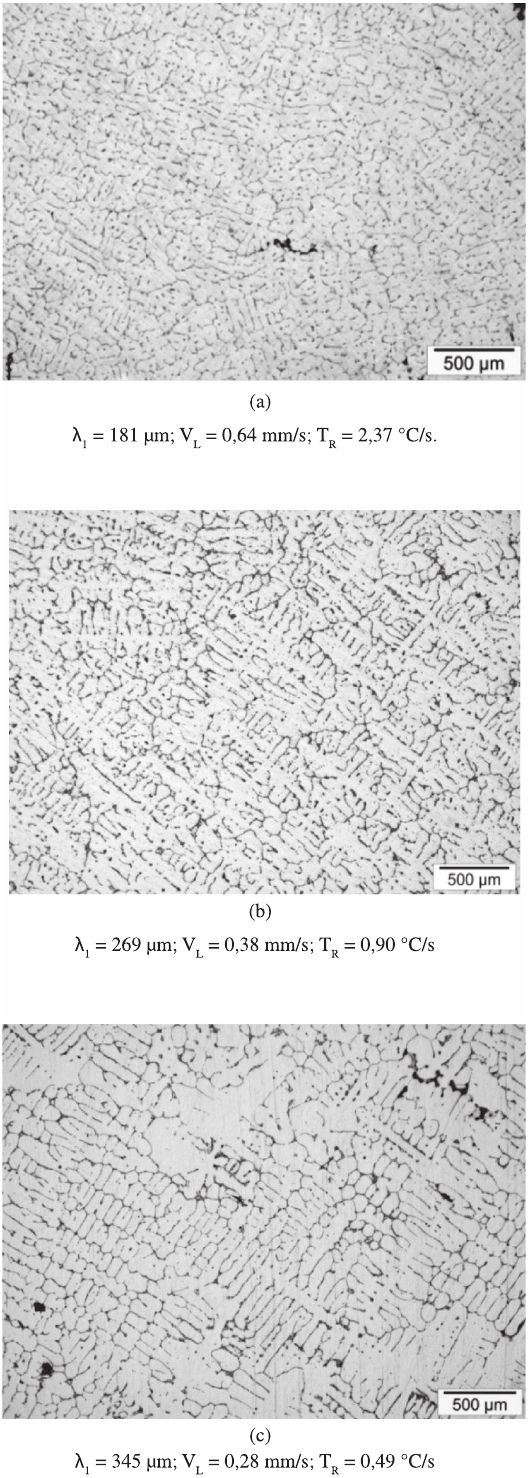
Figure 10. Micrographs of unidirectionally solidified Al-3wt.%Si alloy cross section showing the variation in primary interdendric spacings with the distance from the cooled stainless steel chill. (a) Distance from chill 10 mm, (b) Distance from chill 30 mm, and (c) Distance from chill 60 mm.